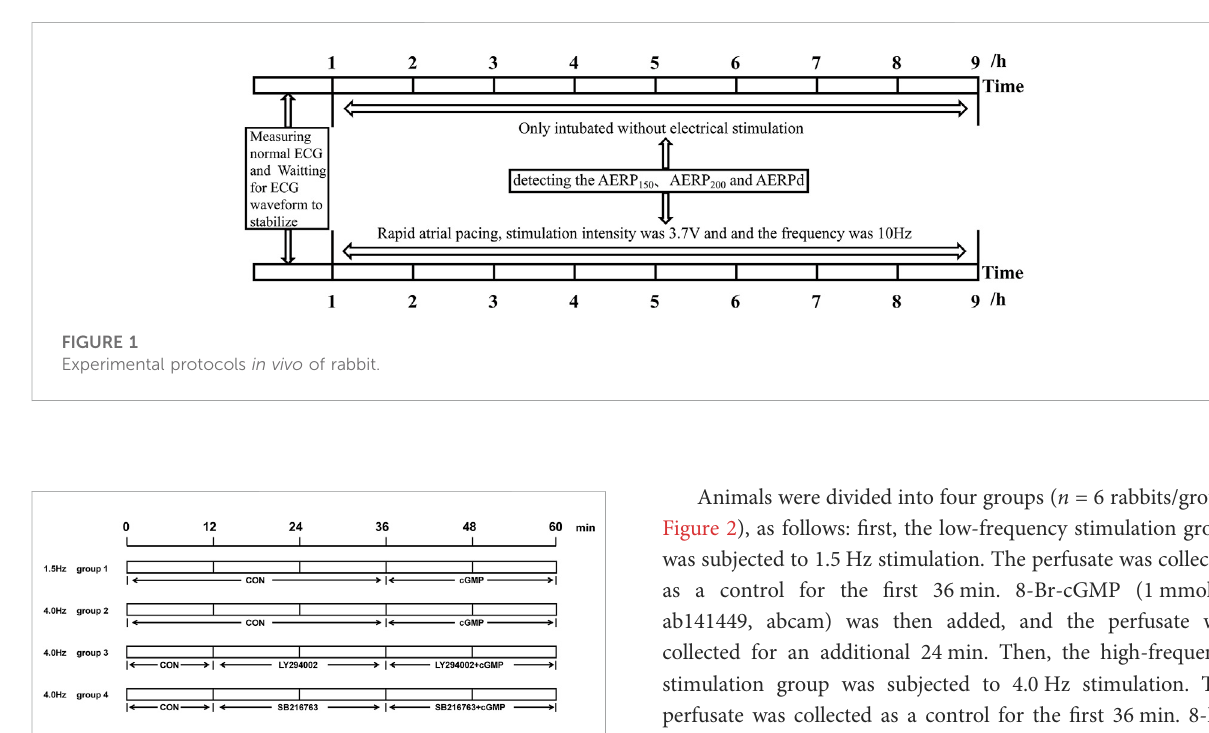
FIGURE 2 Experimental protocols in vitro . The order and time of adding of perfusion reagents for each group in the isolated perfusion